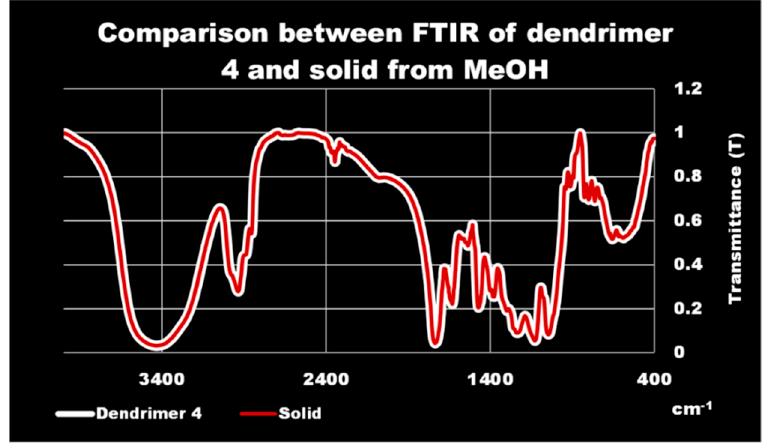
Figure 7. Comparison between FTIR of dendrimer 4 (black) and solid from MeOH (red).